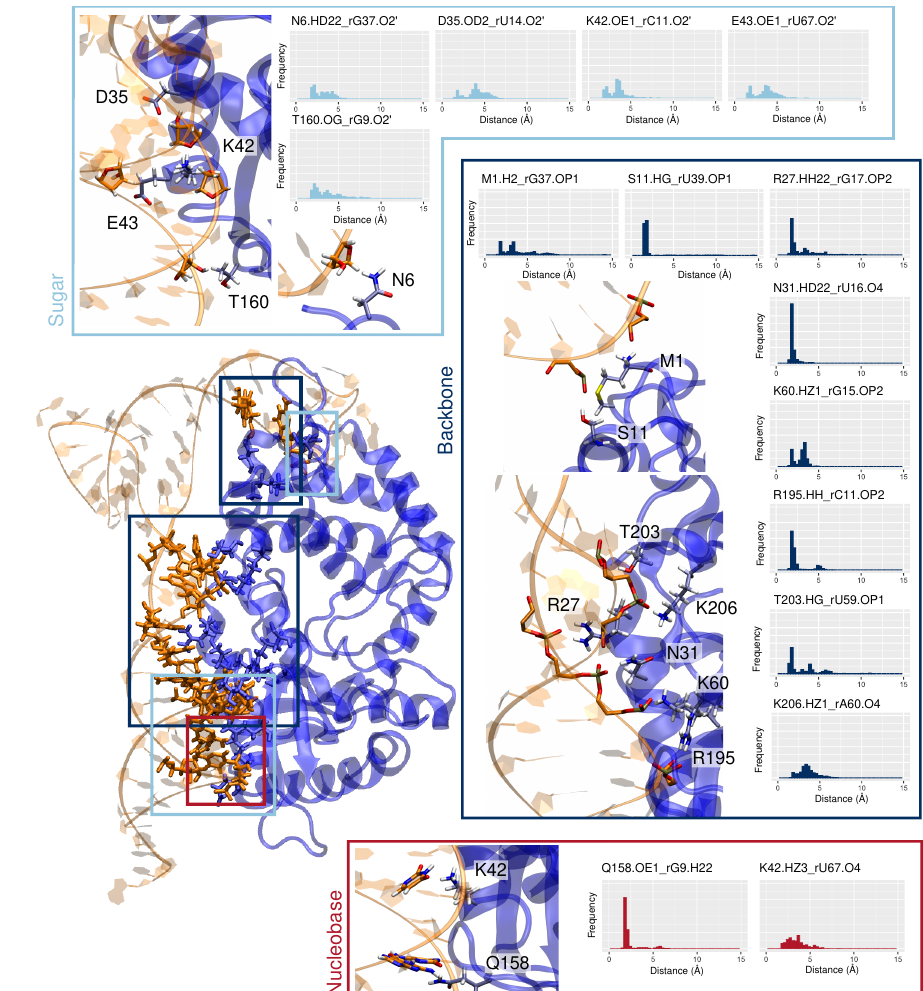
Figure 5. Representation and frequencies of the major interactions between OAS1 residues and the sugar rings (RNA-specific, light blue), backbone (non-specific, dark blue), or nucleobases (sequence- specific,